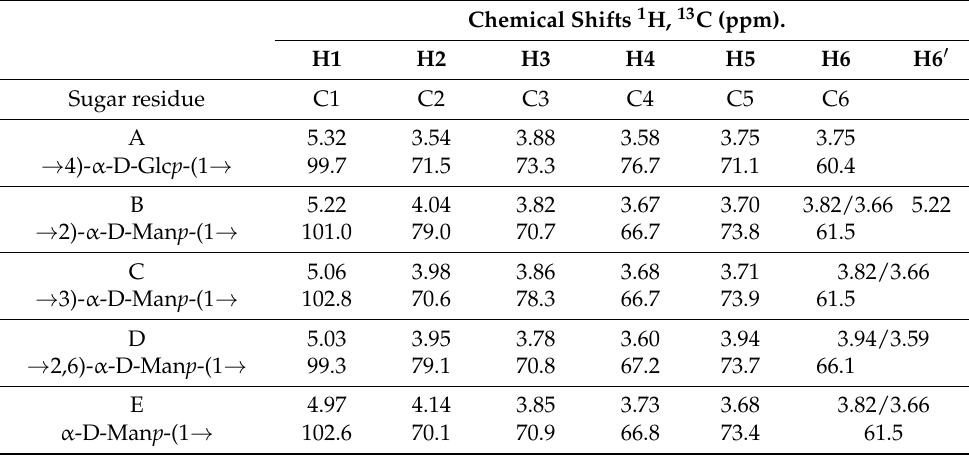
Table 1. 1 H and 13 C NMR chemical shifts of sample Se-exopolysaccharides fraction.